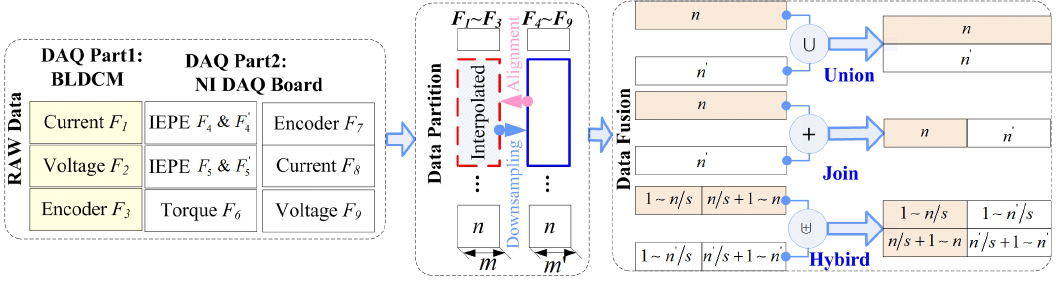
Figure 5. Hybrid data fusion